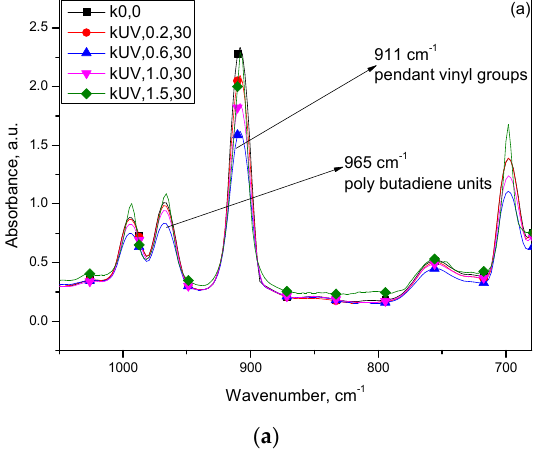
Scheme 2. Plausible reaction scheme of vinyl functionality in the butadiene segments.